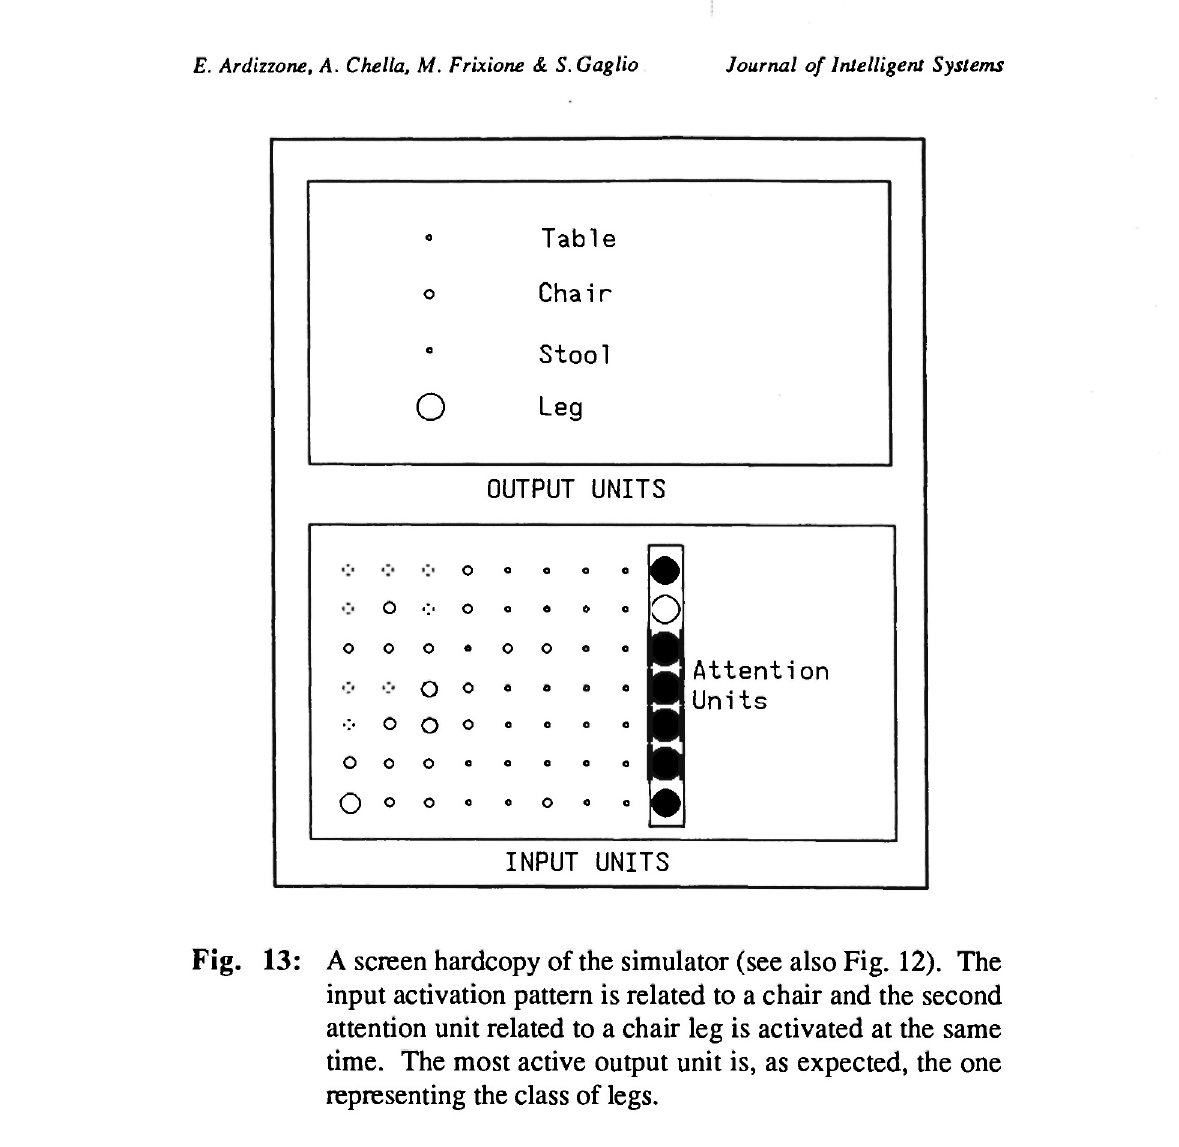
A screen hardcopy of the simulator (see also Fig. 12). The input activation pattern is related to a chair and the second attention unit related to a chair leg is activated at the same time. The most active output unit is, as expected, the one representing the class of